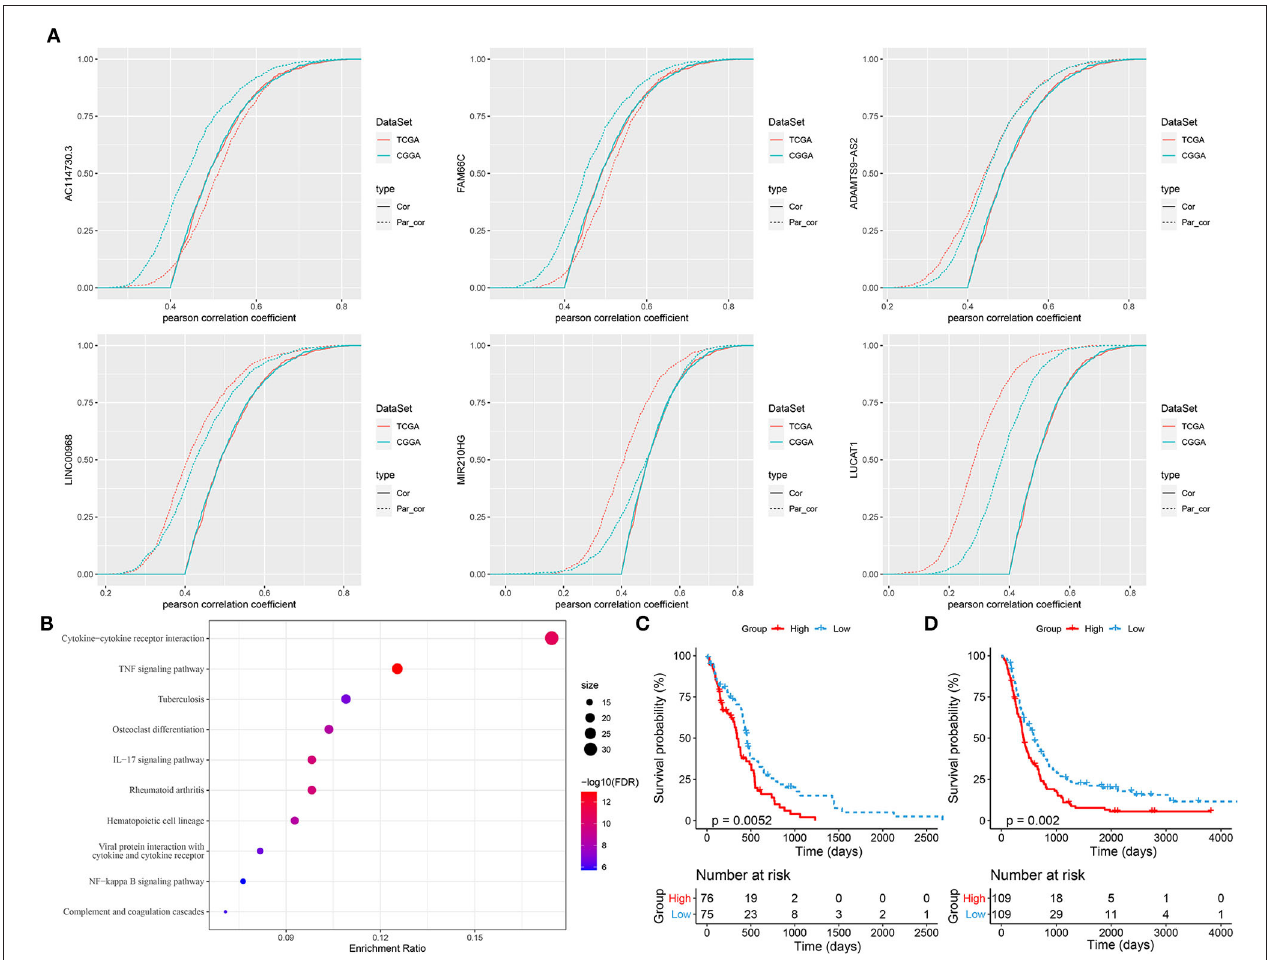
FIGURE 8 | Identifying key hypoxia-related long non-coding RNAs (lncRNAs). (A) First-order partial correlation analysis among hypoxia score, expression of hypoxia-related genes, and lncRNAs. Green and red curves indicate GSE108474 and TCGA-GBM datasets, respectively. Solid and dotted curves indicate the correlation between hypoxia score and expression of hypoxia-related genes before and after removing the effect of lncRNAs, respectively. (B) GSEA of hypoxia-related genes associated with three key lncRNAs. Size indicates gene counts. (C,D) Kaplan–Meier survival plots of high-risk and low-risk groups classified by three key lncRNAs in TCGA-GBM (C) and CGGA-GBM (D)